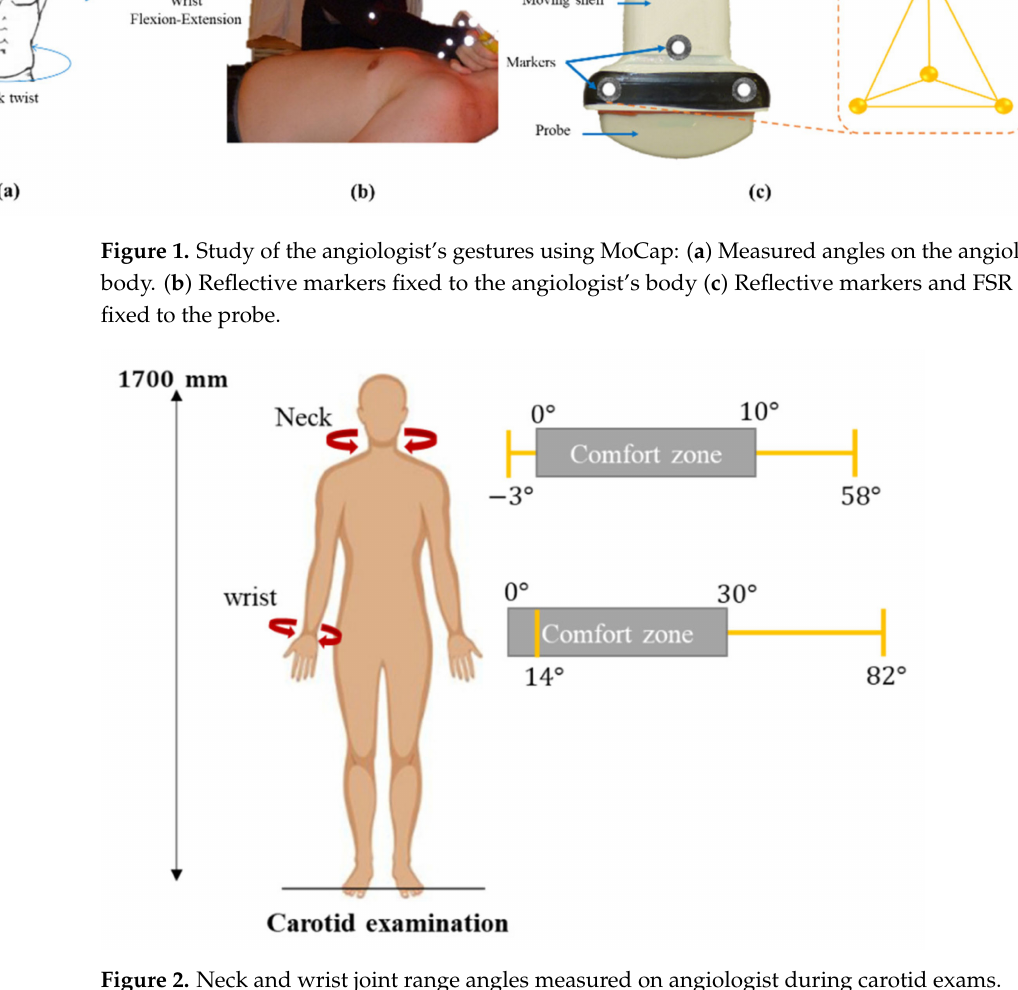
Figure 2. Neck and wrist joint range angles measured on angiologist during carotid